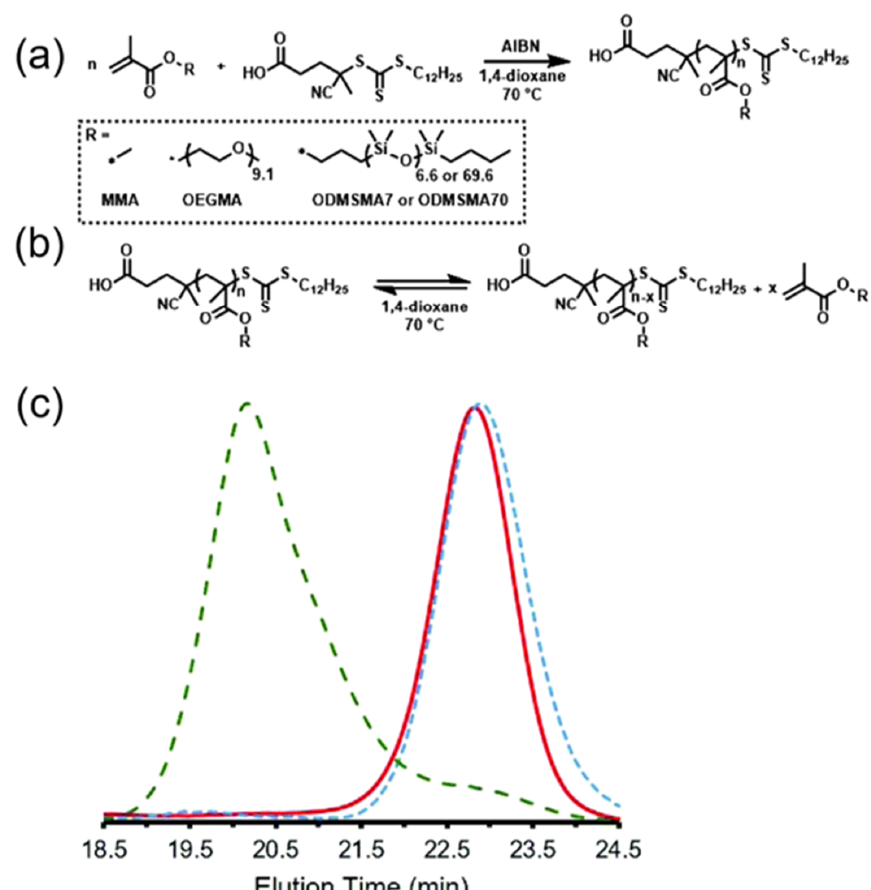
Figure 9. Reversible polymerization in a RAFT system. ( a ) Preparation of brush-type polymers via RAFT polymerizations of methacrylate monomers; ( b ) depolymerization and repolymerization of RAFT polymers; ( c ) GPC trance of original RAFT polymer (red solid line), depolymerized polymer (blue dotted line), and repolymerized polymer (green dotted line). Reproduced with permission from [60].